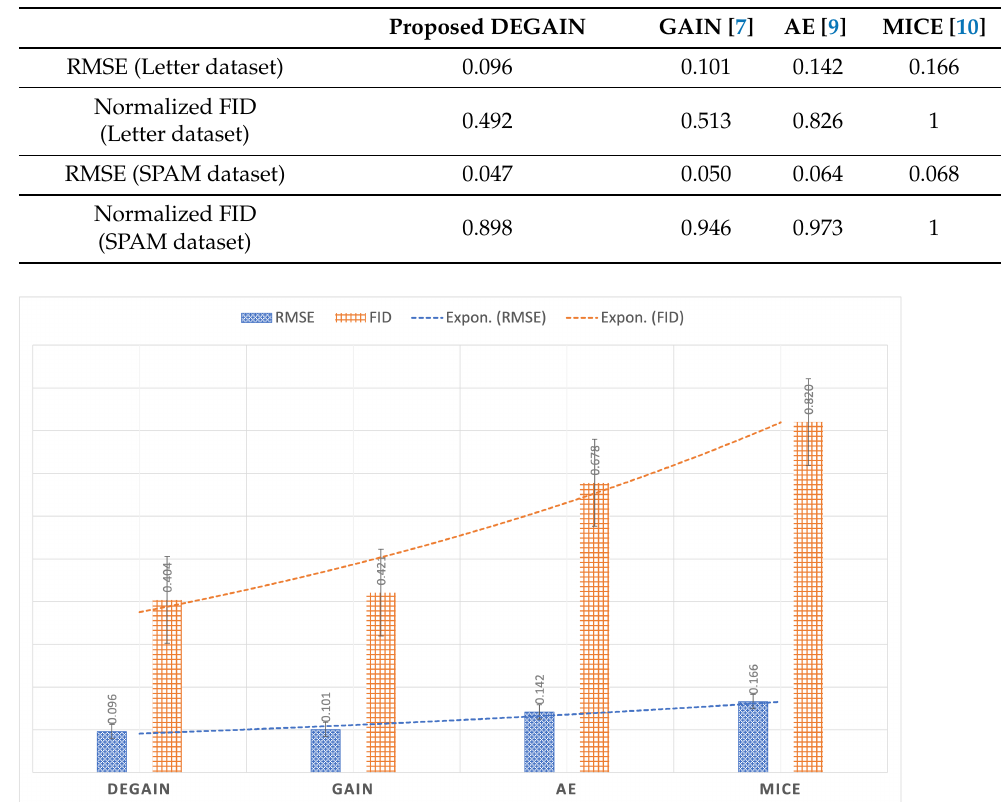
Table 2. Performance evaluations of proposed DEGAIN, GAIN [7], AE [9], MICE [10] in terms of RMSE and FID metrics.